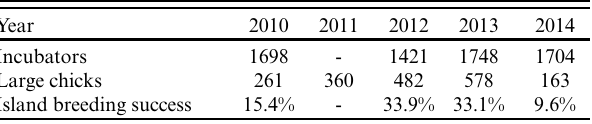
Table 2 . Island wide Tristan Albatross ( Diomedea dabbenena ) counts for years 2010 - 2014.